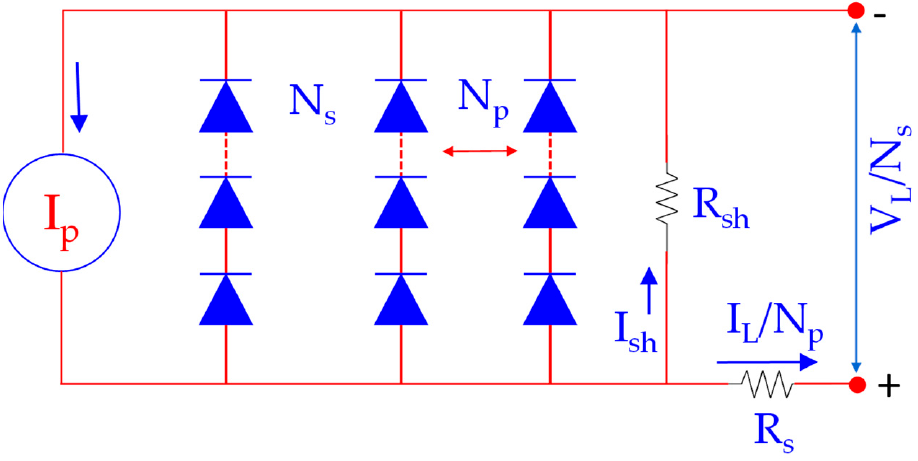
Figure 1. PV panel module equivalent circuit.